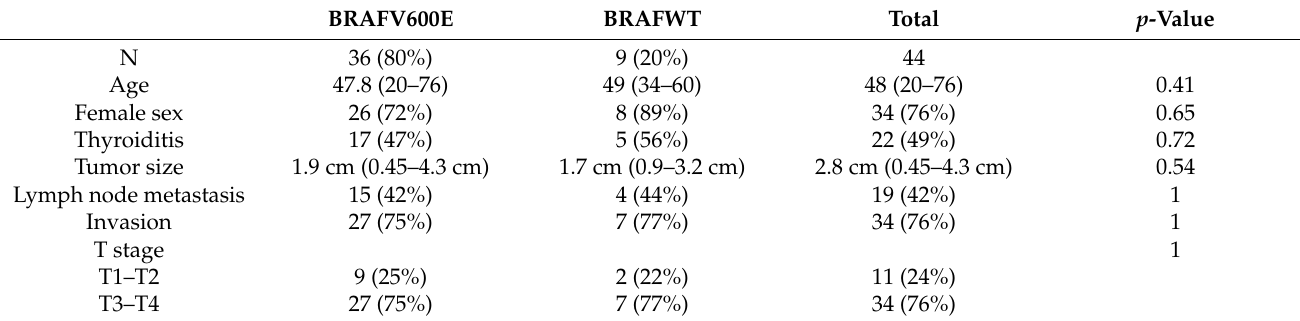
Table 1. Patient demographic and clinicopathological